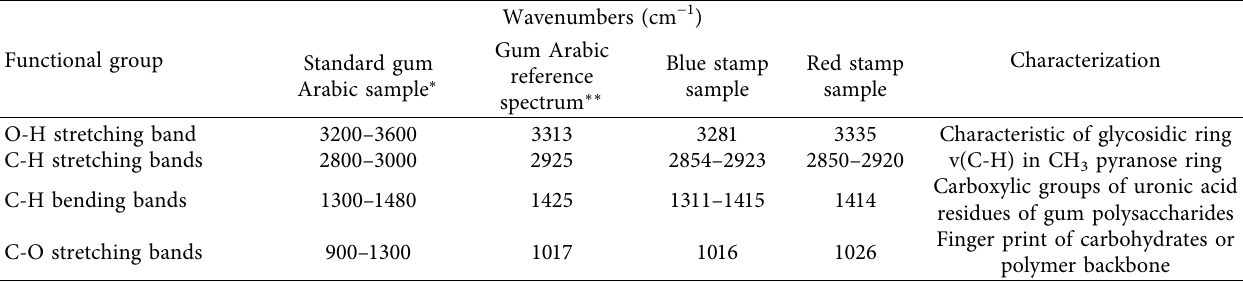
Table 5: The similar functional groups for the FTIR spectrum of the adhesive sample on the back side of the blue stamp, which turned out to be gum Arabic